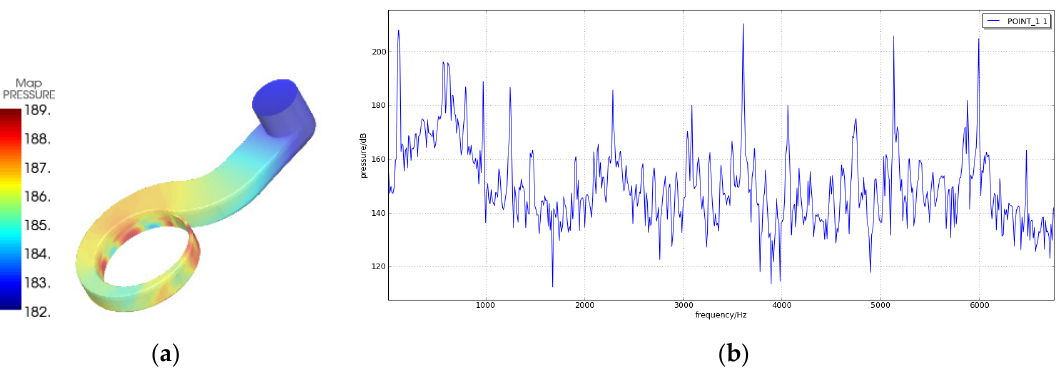
Figure 18. Fluid-borne noise characteristics at Q r : ( a ) the L p contour at 6 f 0 with unit dB; ( b ) spectrum